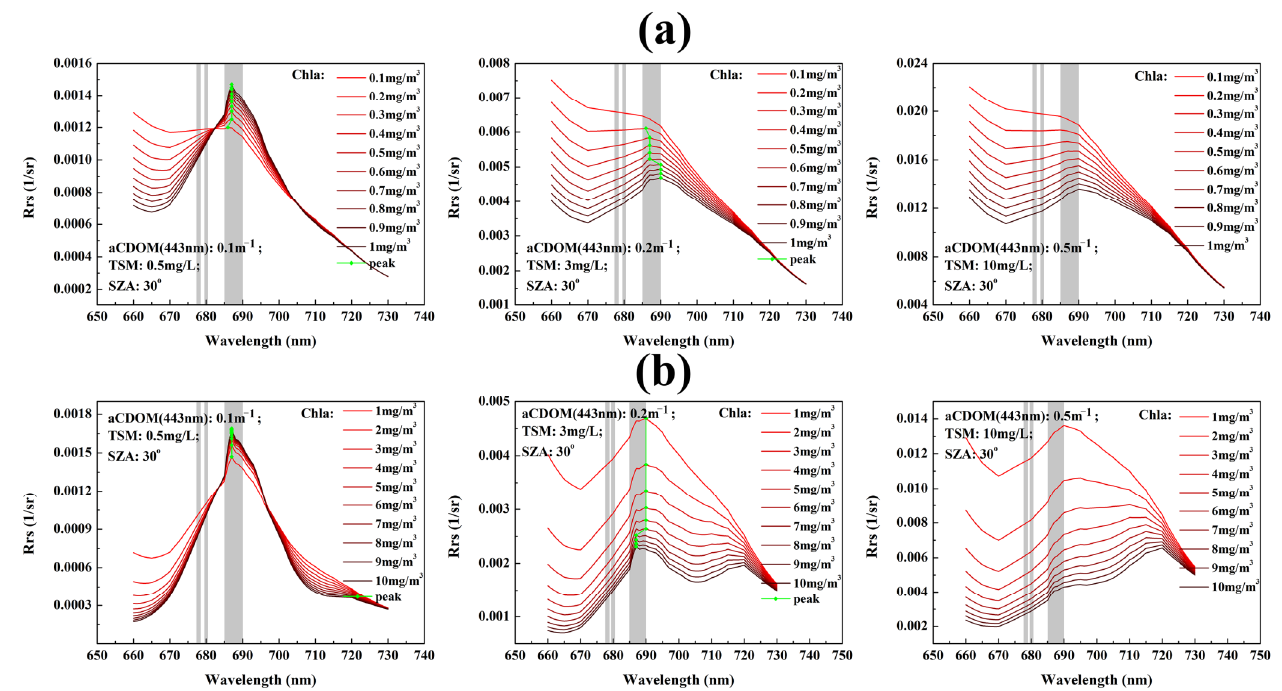
Figure A1. Effects of CDOM and TSM changes in different Chla water bodies. ( a ) Chla are 0.1–1 mg/m 3 , and ( b ) Chla are 1–10 mg/m 3 .